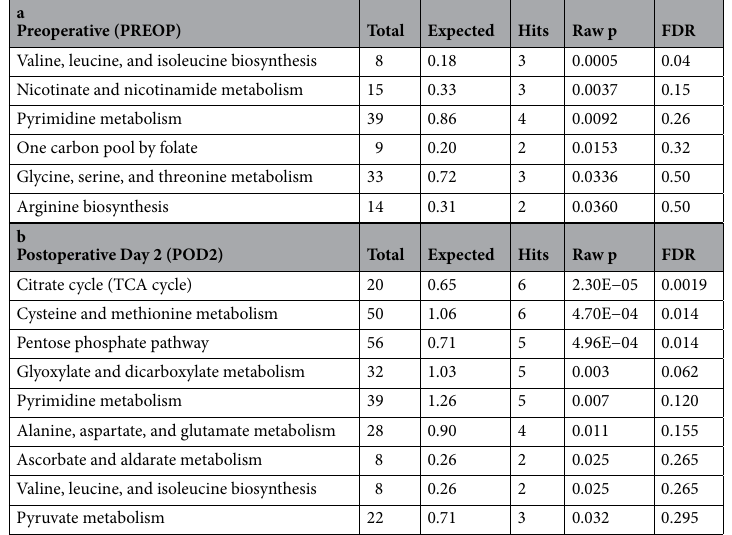
Table 2. Metabolites with significant differential concentrations between delirium and control groups. Metabolites were considered significant if they passed two or more statistical tests. The AVG-p is the average of the p values that passed cutoff. Variable importance in projection (VIP) score was obtained from orthogonal partial least squares discriminant analysis (OPLS-DA). VIPs reflect both the loading weights and the variability of each response. Fold-change (FC) of each metabolite was calculated by applying the one-step Tukey’s biweight algorithm on traditionally calculated FC values (Delirium/Control) for each paired sample. A negative FC denotes downregulation in the delirium group. a) PREOP: 37 metabolites statistically significant with a nominal p value < 0.05. b) POD2: 52 metabolites statistically significant with a BH-corrected p value < 0.05. 1 Metabolites found to have significant differentially quantified concentrations in both PREOP and POD2. 2 Those metabolites with an opposite fold change directionality at each time point. 3 The 11-metabolite predictors used for the SVM prediction model at PREOP. 2-Oxobutanate is the only one found to be significant at both PREOP and POD2. 4 The selected reaction monitoring (SRM) transition for this entry allows for detecting both itaconic acid and citraconic acid and is not specific to either. Metabolites included in this entry do not chemically behave as expected under the individual itaconic acid SRM, or the itaconic acid entry would have captured them.